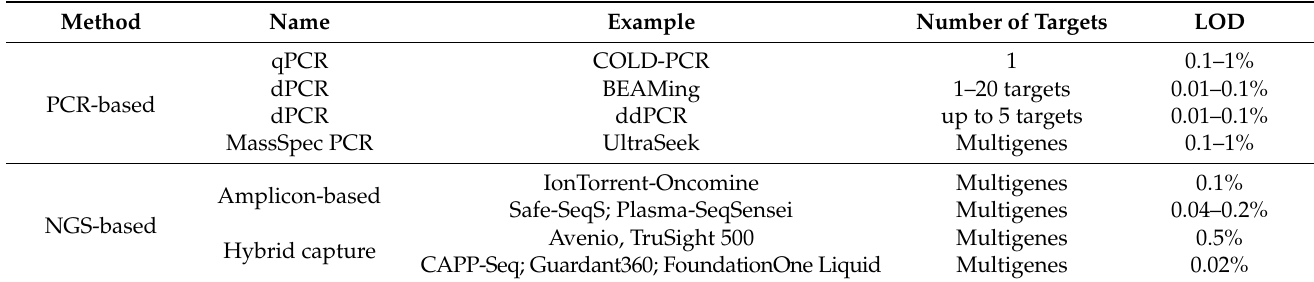
Table 1. Common ctDNA detection